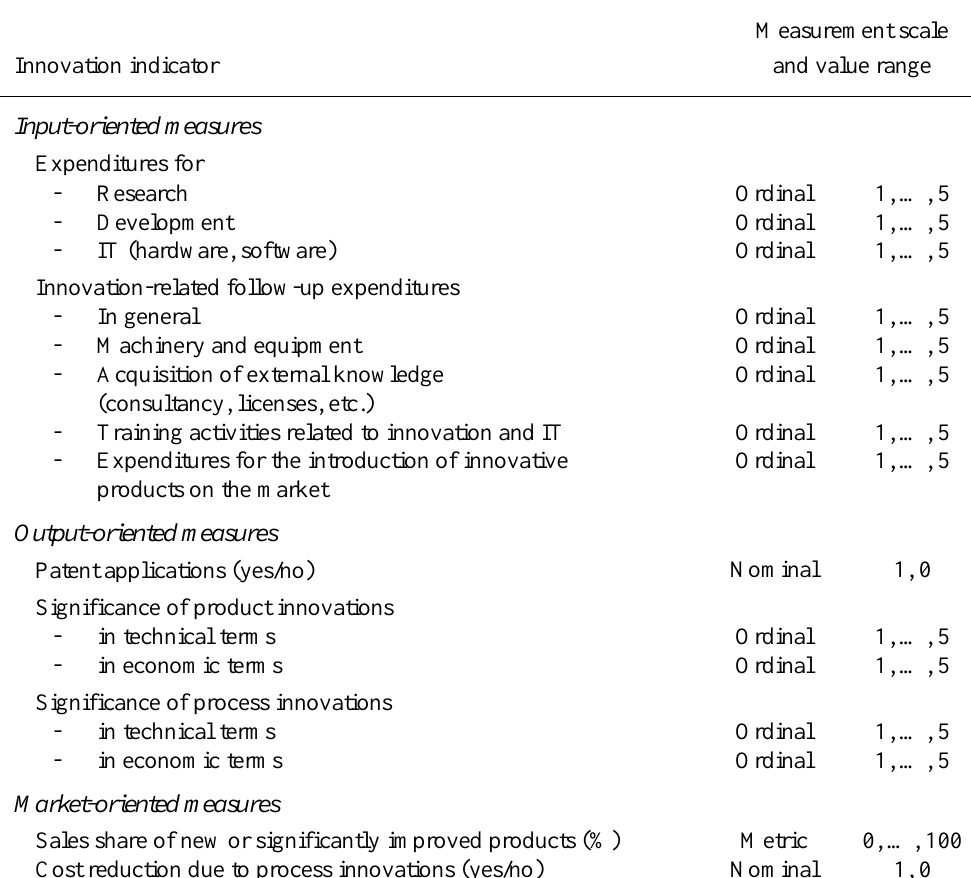
Table 1 : Innovation indicators used in the factor analysis